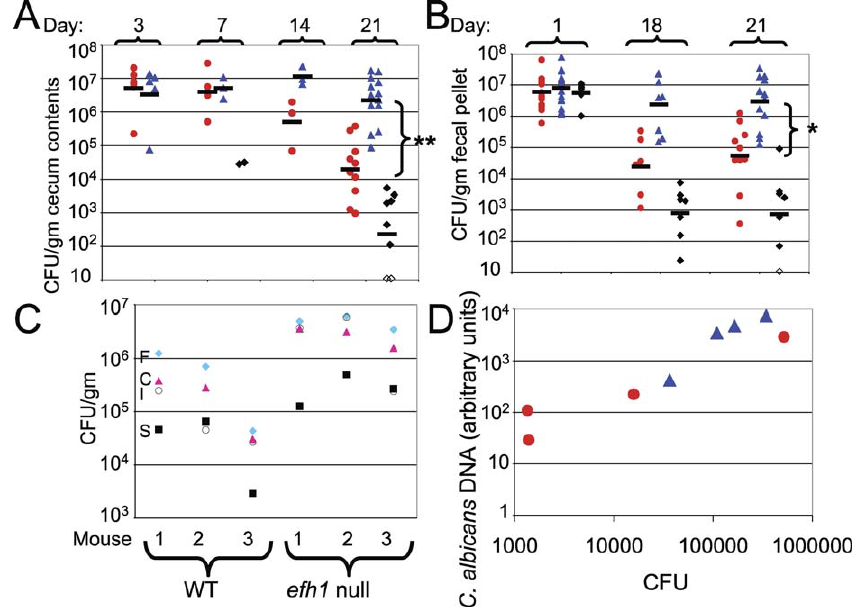
Figure 3. Deletion of EFH1 Alters Murine Intestinal Colonization WT, efh1 deletion mutant, or EFH1 reconstituted null mutant were orally inoculated by gavage into Swiss Webster mice. At various days post- inoculation, the amounts of C. albicans in fecal pellets and in organs of the intestinal tract were measured. (A) CFUs per gram of cecum contents from mice sacrificed on the indicated days post-inoculation. Each symbol represents a sample from a different mouse. (Composite results from several experiments.) Red circles, WT C. albicans strain DAY185 (23 mice); blue triangles, efh1 deletion mutant strain CKY366 (24 mice); black diamonds, EFH1 reconstituted strain, CKY373 (ten mice); open symbols, no colonies detected; bars, geometric means. p -Value was determined using the t test with log transformed data. ** indicates p , 0.000005. (B) CFUs per gram of fecal pellet. Mice were sampled repeatedly and each symbol represents a sample from a different mouse. Different numbers of mice are shown on different days because some mice were sacrificed earlier and some mice were sampled on different days. Red circles, WT C. albicans strain DAY185 (ten mice); blue triangles, efh1 deletion mutant strain CKY366 (12 mice); black diamonds, EFH1 reconstituted strain, CKY373 (seven mice); open symbols, no colonies detected; bars, geometric means. p -Value was determined using the t test with log transformed data. * indicates p , 0.0003. (C) Correlation between CFUs measured in several organs and in fecal pellets. Light blue diamonds, fecal pellets (labeled F); pink triangles, cecum contents (labeled C); open circles, ileum contents (labeled I); squares, stomach contents (labeled S). CFU/gm of cecum contents, stomach contents, and fecal pellets correlated well, while the CFU/gm ileum was more variable. (D) Mice were colonized with WT strain DAY185 (red circles) or efh1 null mutant CKY366 (blue triangles) or were not inoculated with C. albicans (not shown). Mice were sacrificed on day 21 post-inoculation, CFUs from cecum contents were determined by plating, and C. albicans DNA in cecum contents was quantified by qPCR as described in Materials and Methods. The correlation between CFUs in 70 mg of pelleted cecum contents ( x -axis) and DNA (in arbitrary units) determined by qPCR ( y -axis) is shown. Each symbol represents a different mouse.